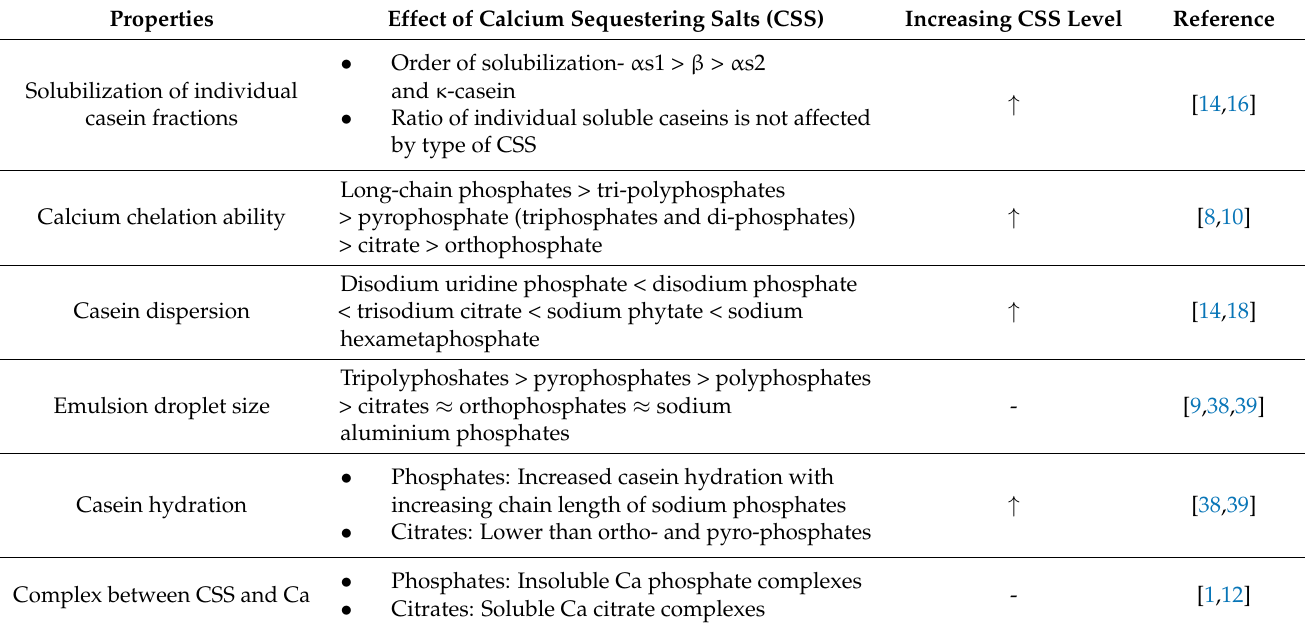
Table 2. Effect of different calcium sequestering salts on the properties of casein